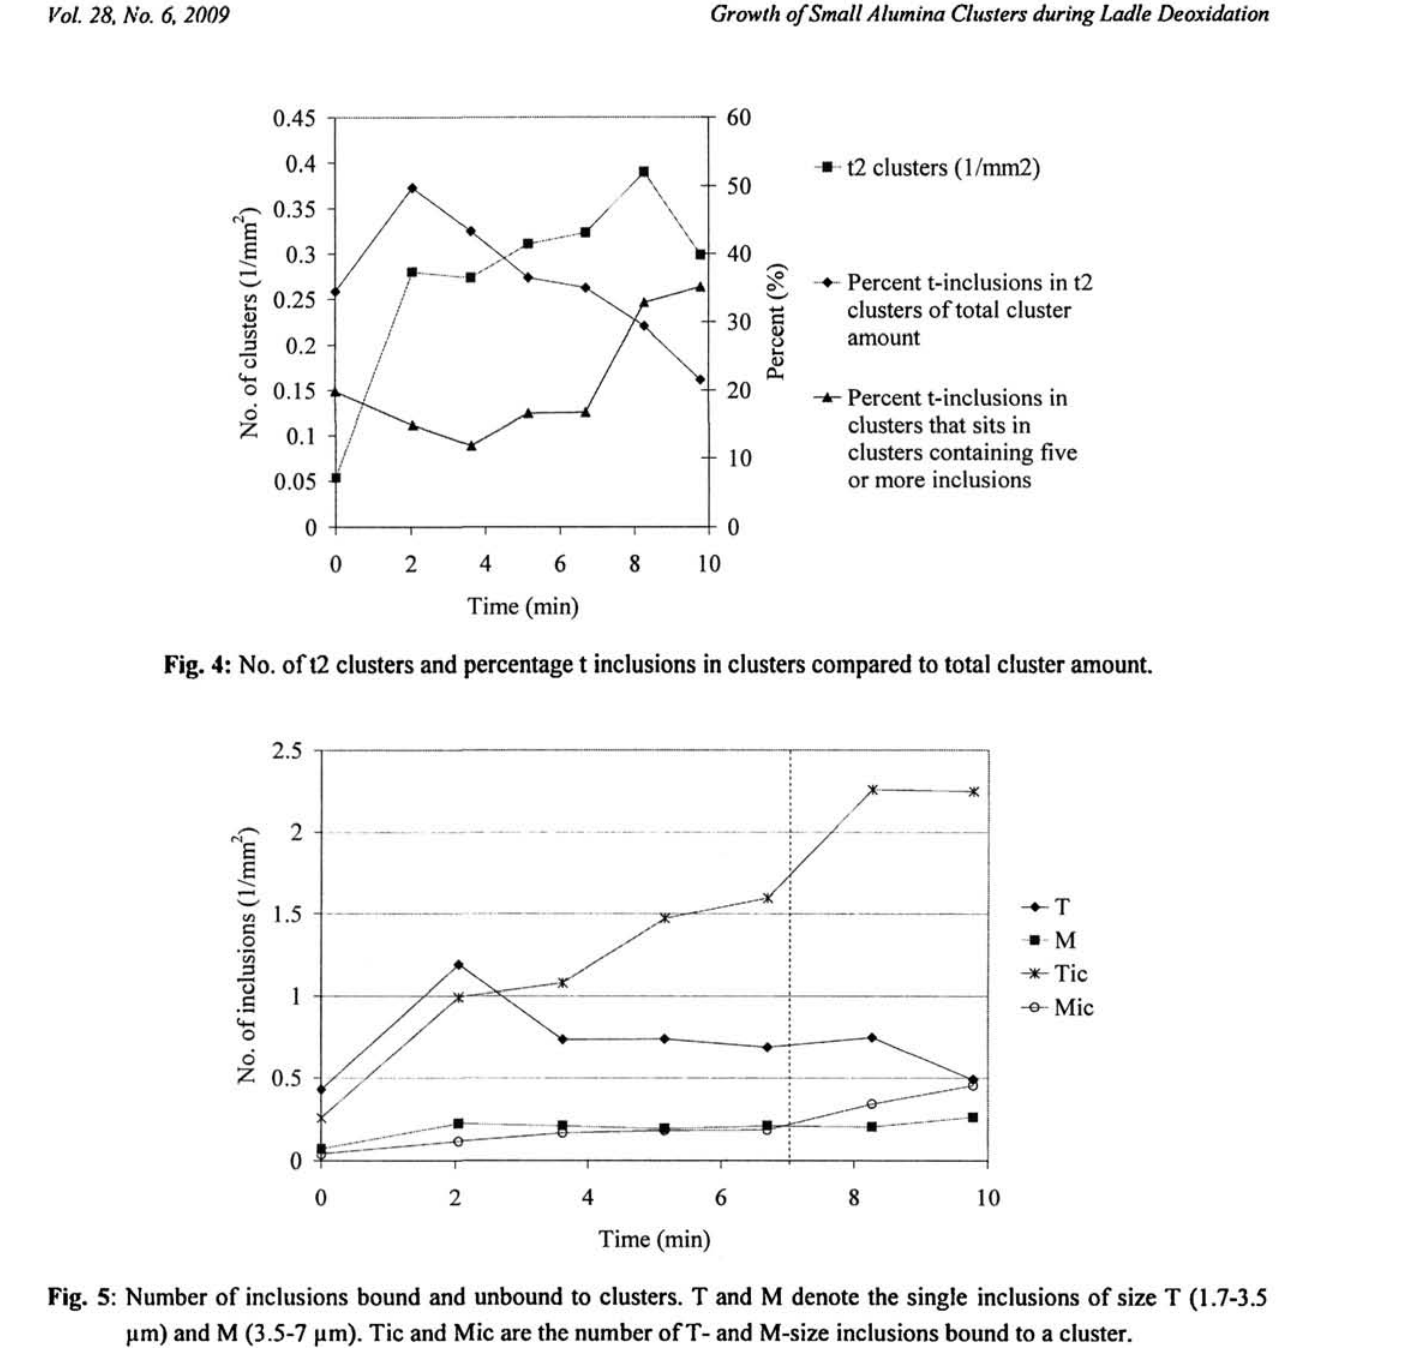
Fig. 5: Number of inclusions bound and unbound to clusters. T and M denote the single inclusions of size T (1.7-3.5 μπι) and Μ (3.5-7 μιη). Tic and Mic are the number of T- and M-size inclusions bound to a